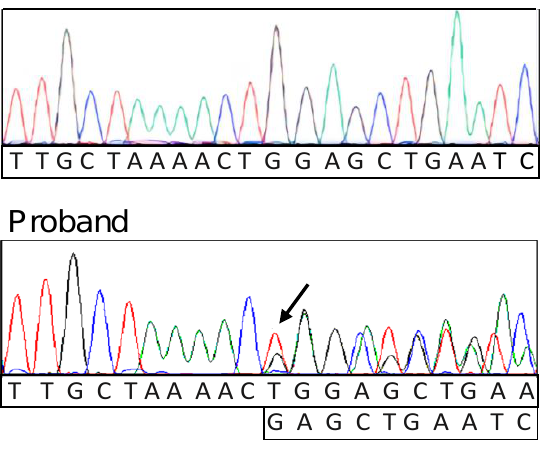
Figure 3. Trio sanger analysis showing the genotype of the parents and the proband at RAD21 locus. The arrow indicates the NM_006265.2:c.1722-1723del in heterozygosis.